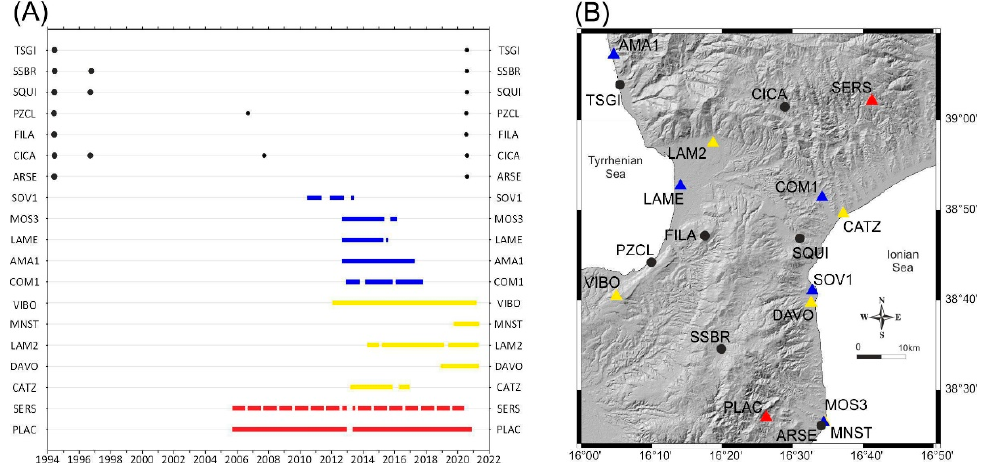
Figure 7. ( A ) Occupations of the benchmarks belong to the IGM95 Network (black dots); permanent stations computed by the Nevada Geodetic Laboratory (http://geodesy.unr.edu, accessed on 1 September 2021) are in blue rectangles; the stations belong to the TopNET Live (https://www.topnetlive.com, accessed on 1 September 2021) and RING/RDN networks are represented by yellow and red rectangles, respectively; ( B ) Distribution of the GNSS stations (the colours indicate the networks).